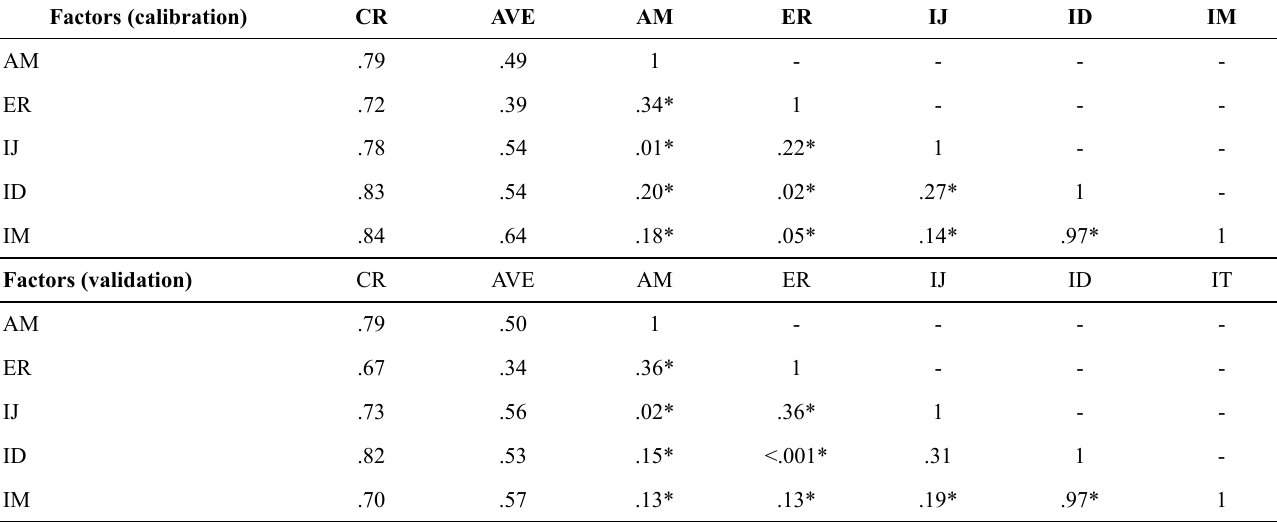
3 Internal reliability, convergent and discriminant validity and average variance extracted – Calibration and Validation samples Factors (calibration)